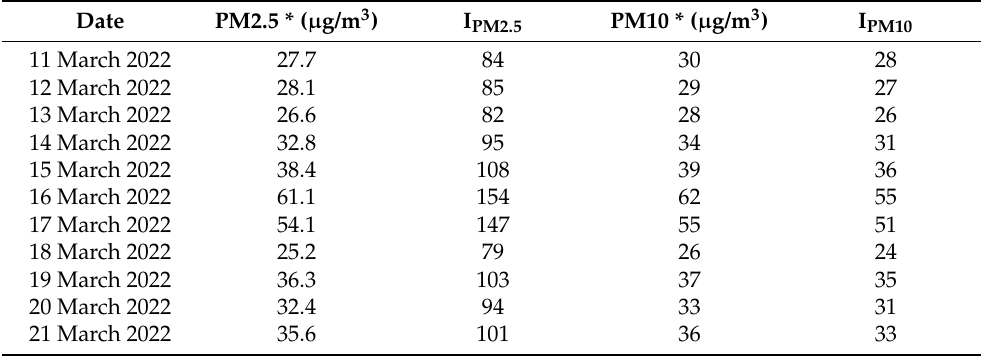
Table 10. Air Quality Index for the garden